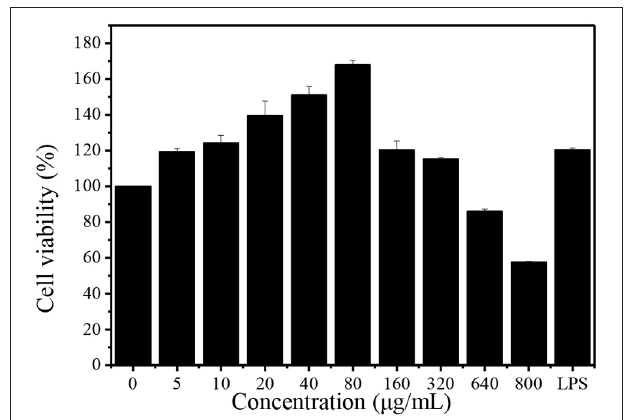
FIGURE 6 | Effect of DHPs-1 on the viability of RAW264.7